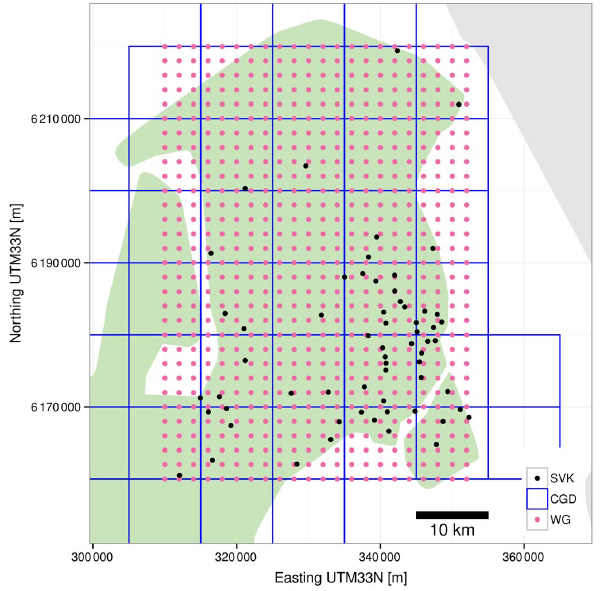
Figure 1. Locations of the rain gauges (SVK), the gridded data set (CGD), and extent of the modelled grid (WG) in the north- eastern part of Zealand (Denmark) including Copenhagen in the south-eastern part of the map where the concentration of SVK gauges is the highest.